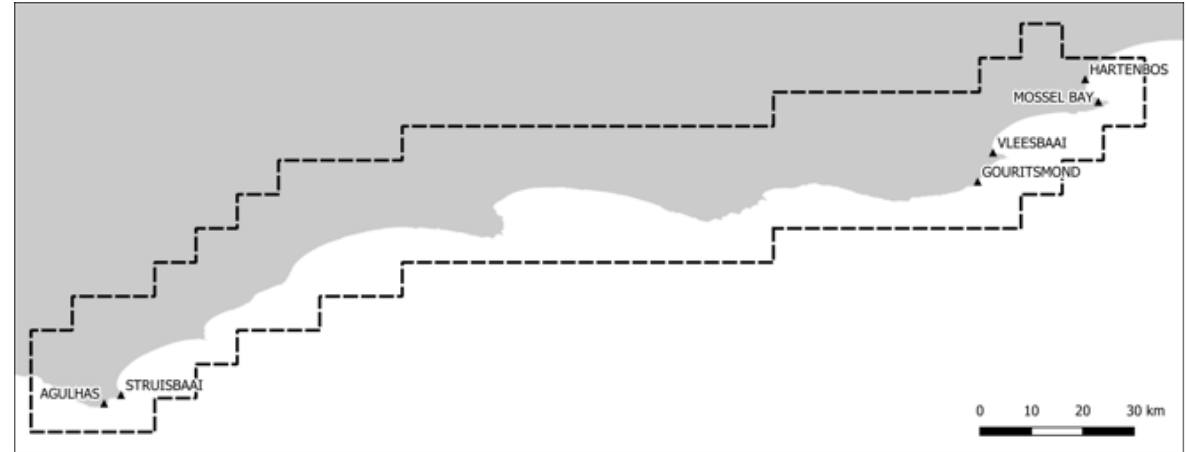
Figure 4. Coastal area for which data was collected in the first mapathon